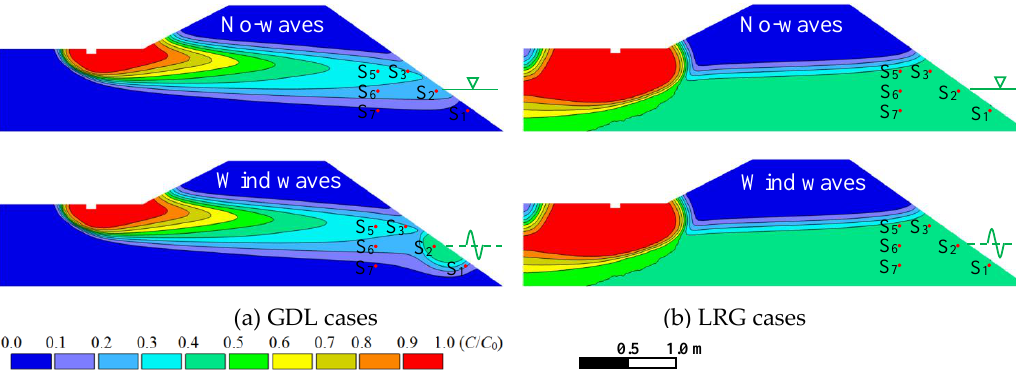
Figure 7. Chloride concentration profiles in the subsurface zone at no-wave (top) and wave (bottom) conditions in the GDL ( a ) and LRG ( b ) cases. Distributions of chloride in both no-wave and wave conditions are the final results of one-day simulations starting from respective initial conditions (steady-state). Red points represent the locations of observation points for chloride